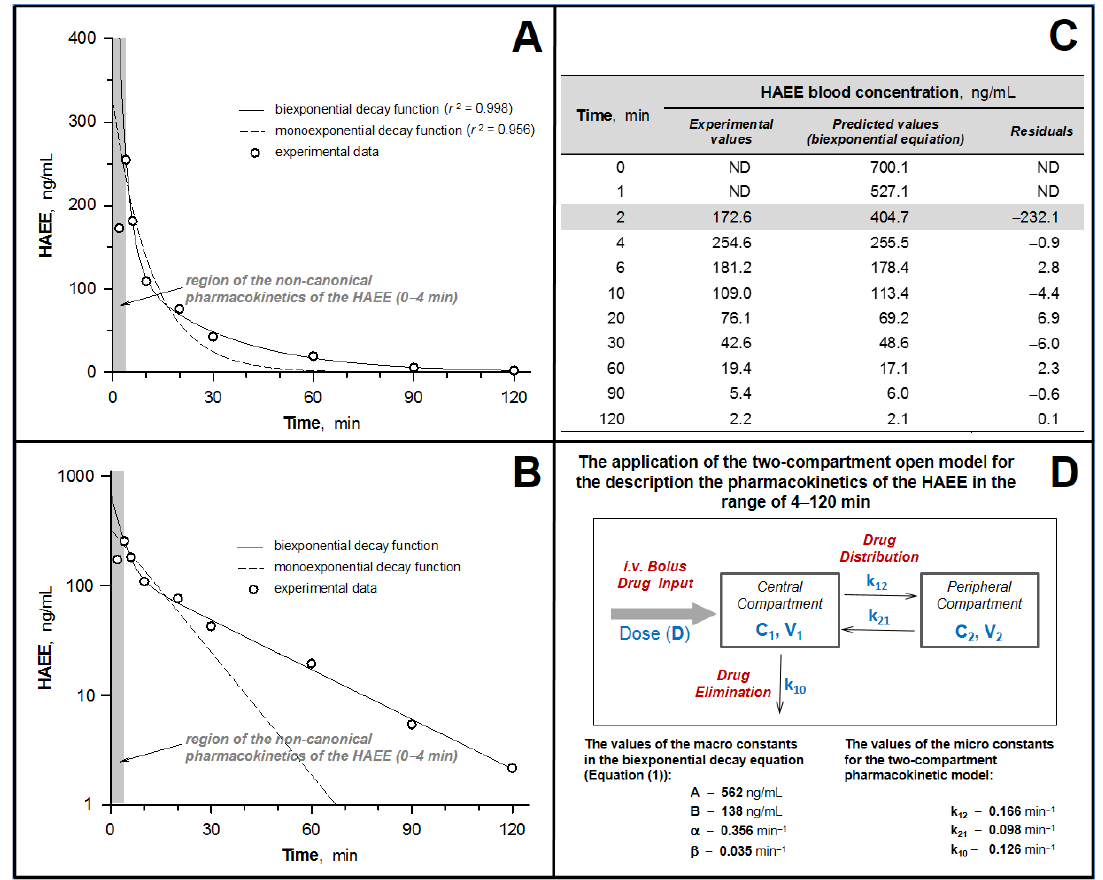
Figure 1. Pharmacokinetics of HAEE in rabbit blood after a single intravenous (i.v.) bolus injection at a dose of 120 µ g/kg. ( A , B ). Approximation of experimental data by equations of mono- and bi-exponential decay functions. Data are presented in straight ( A ) and semi-logarithmic ( B ) coordinates. ( C ). Deviation of experimental data from the results predicted by the biexponential decay function in the time range 0–4 min. ( D ). Calculation of pharmacokinetic parameters in an open two-compartment model for i.v. bolus administration in the time range 4–120 min.